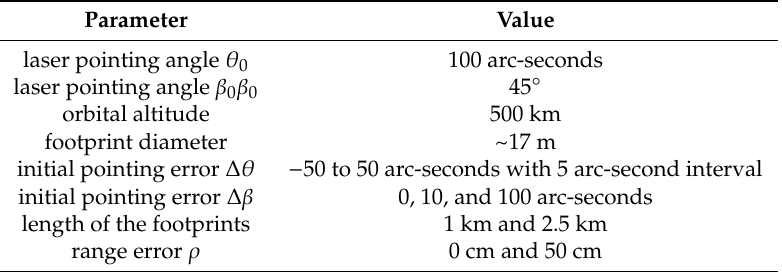
Table 2. Simulation parameters.